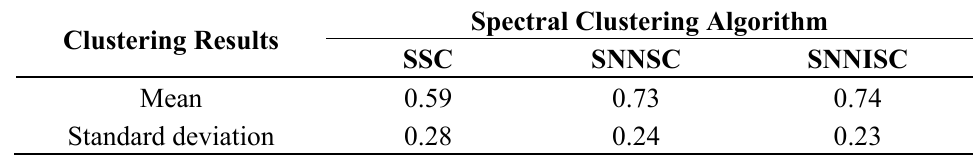
Table 5. Mean and standard deviation of ARIs of different spectral clustering